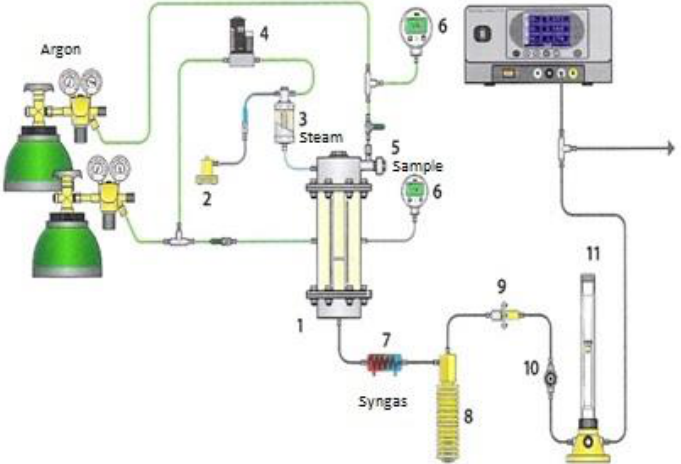
Figure 1. Laboratory equipment for the analysis of gasification: (1) reactor, (2) water pump, (3) steam generator, (4) mass flow meter, (5) fuel feeder, (6) manometer, (7) cooler, (8) condensate tank, (9) filter, (10) pressure regulator, and (11) rotameter.